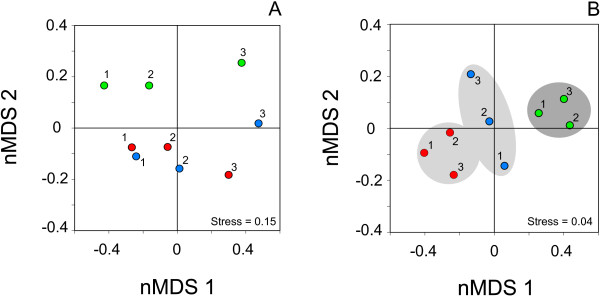
Non-metric multidimensional scaling (nMDS) plots showing the ordination patterns of macroinvertebrate communities. A is the nMDS plot based on the log-transformed abundance of the species and B is the same plot based on the species specialization index (SSI). Red, blue, and green circles represent halt (1997-2002), eutrophication (2003-2005), and post-recovery (2006-2010) periods, respectively. Distances between points represent the difference according to the Bray-Curtis dissimilarity, with light grey and dark grey ellipses showing the pre- and post-recovery clustering of points, respectively.